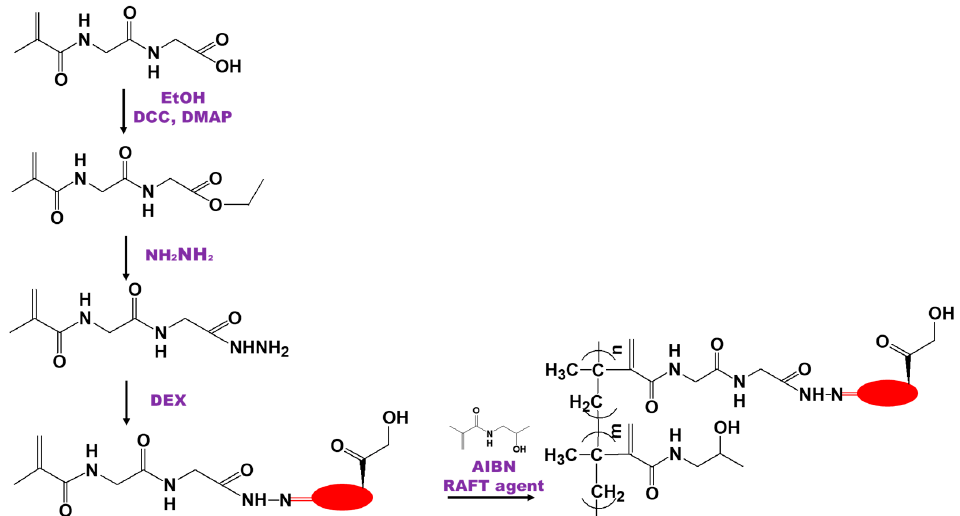
Figure 6. Scheme of the synthesis of dexamethasone-(hydroxypropyl)methacrylamide conjugate by reversible addition fragmentation-chain transfer polymerization [84]. reversible addition fragmentation-chain transfer polymerization